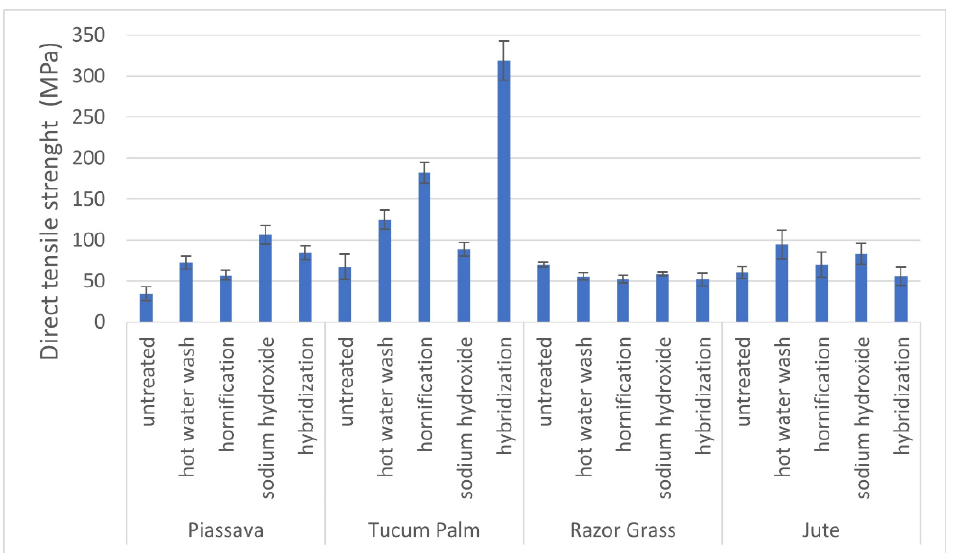
Figure 5. Direct tensile strength of untreated and treated fibers. Four fibers: piassava, tucum palm, razor grass, and jute.